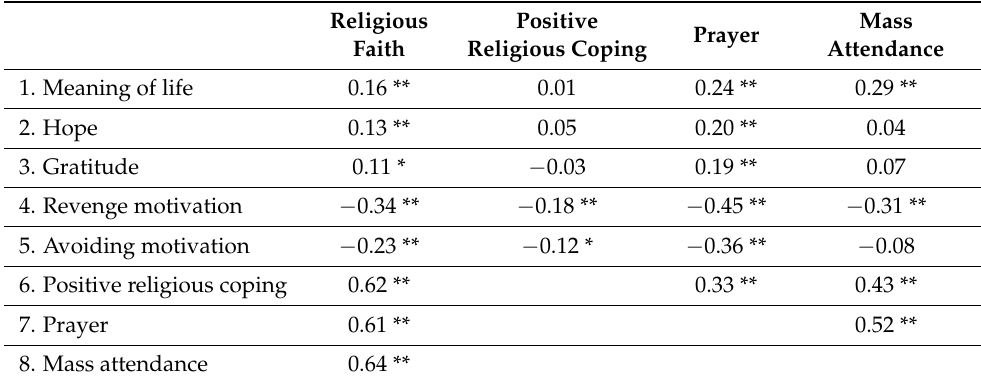
Table 2. Correlation matrix for research variables.